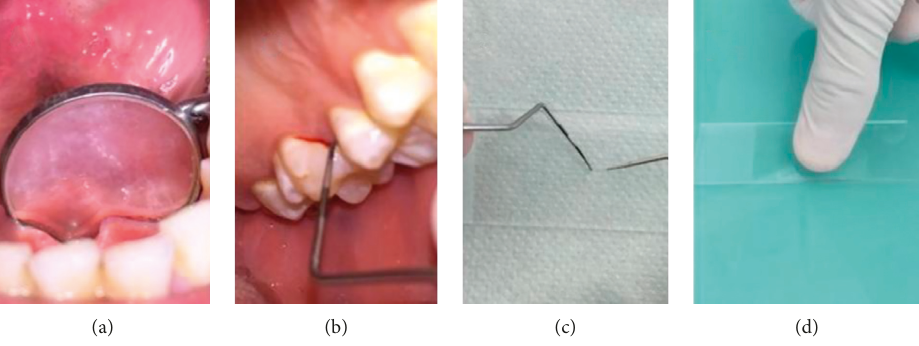
Figure 2: Step-by-step procedure for